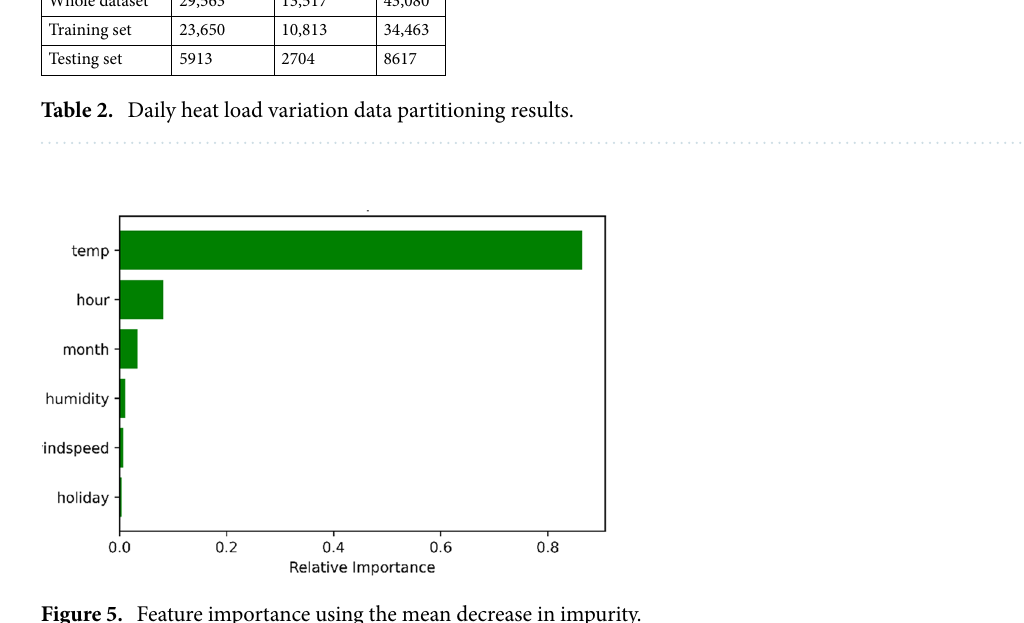
Figure 5. Feature importance using the mean decrease in